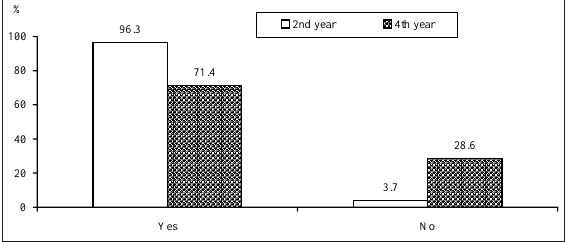
Fig. 3. Results of answers to the question “Are you going to work in the sphere of tourism and sport?”